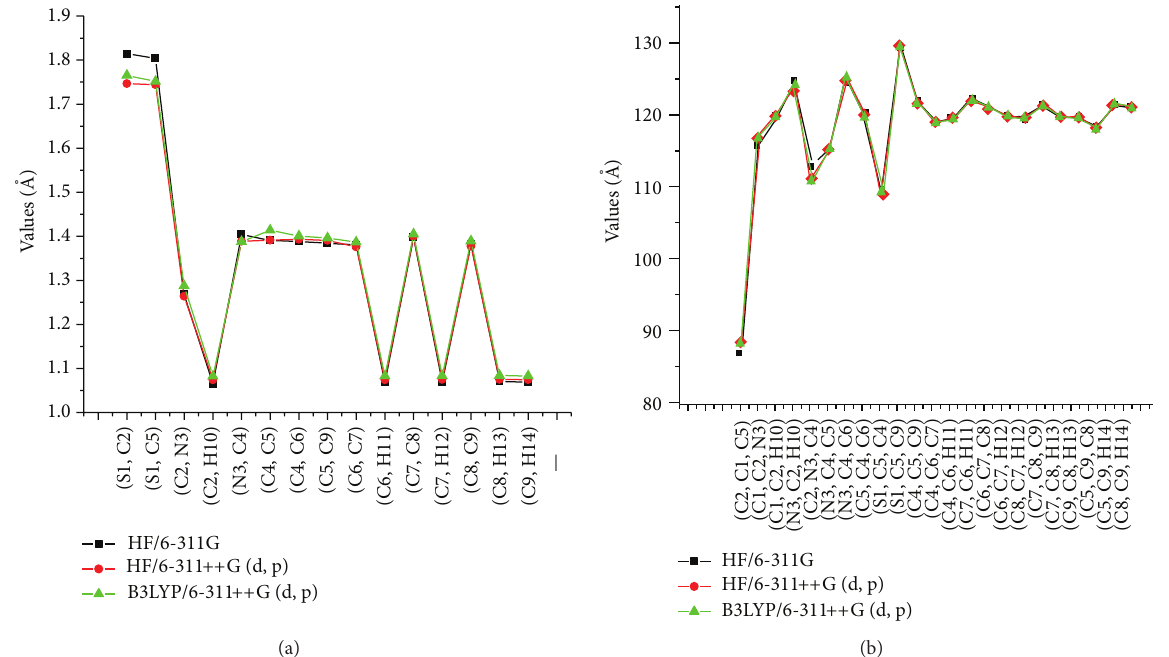
Figure 2: Bond length and bond angle difference between theoretical (HF and DFT)